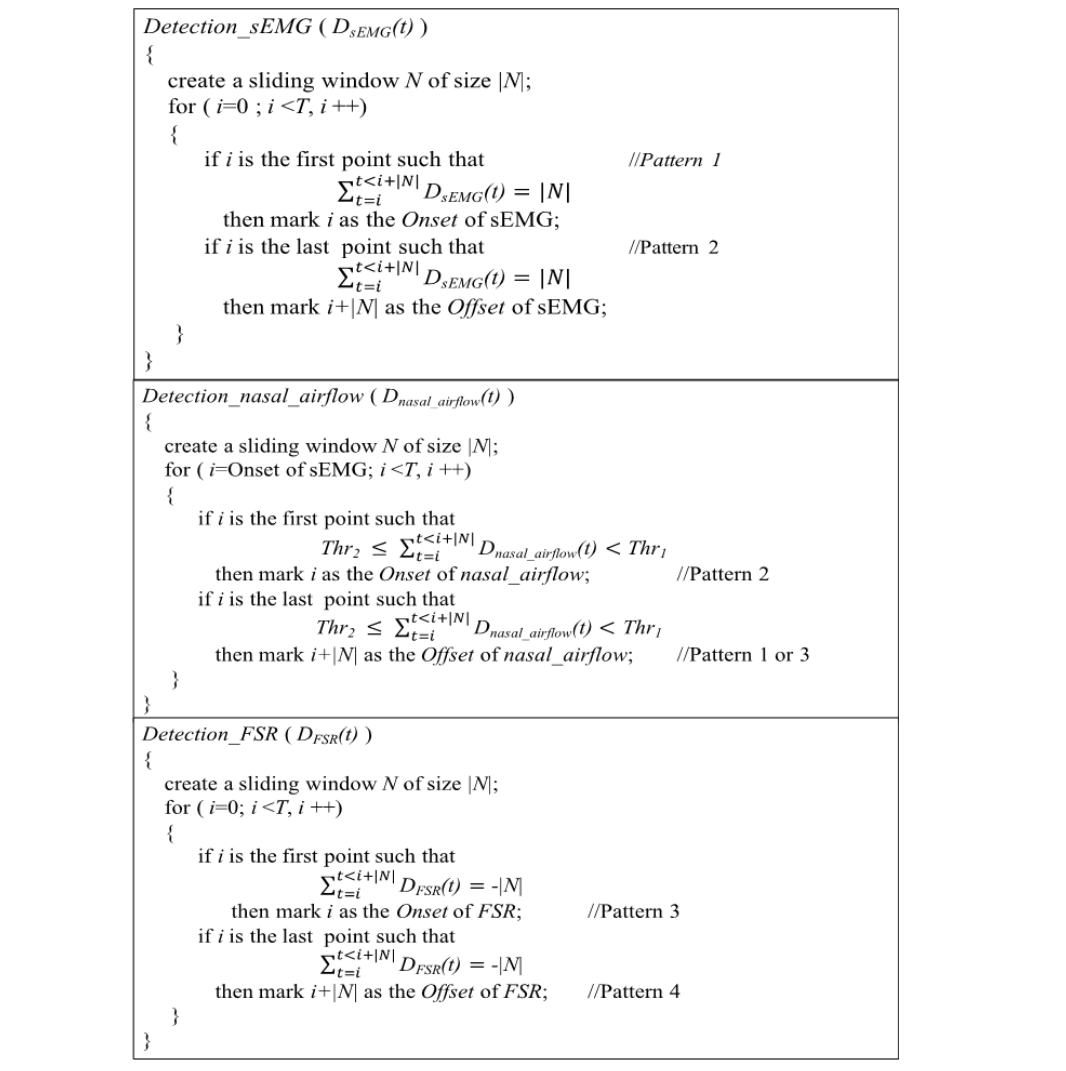
Algorithm 1: The detection of the onset and the o ff set for sEMG, nasal airflow, and FSR.